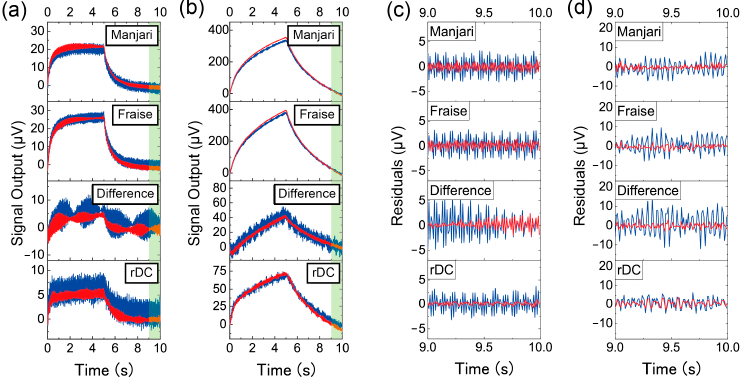
Figure 4. Raw (blue) and averaged (red) sensing outputs from ( a ) the PPPO-coated MSS and ( b ) the PS-coated MSS. Residuals of sensing outputs for the linear fit over the time period of 9.0 to 10.0 s (green-shaded area in ( a ) and ( b )) for ( c ) the PPPO-coated MSS and ( d ) the PS-coated MSS. Blue and red lines indicate raw and averaged sensing outputs,